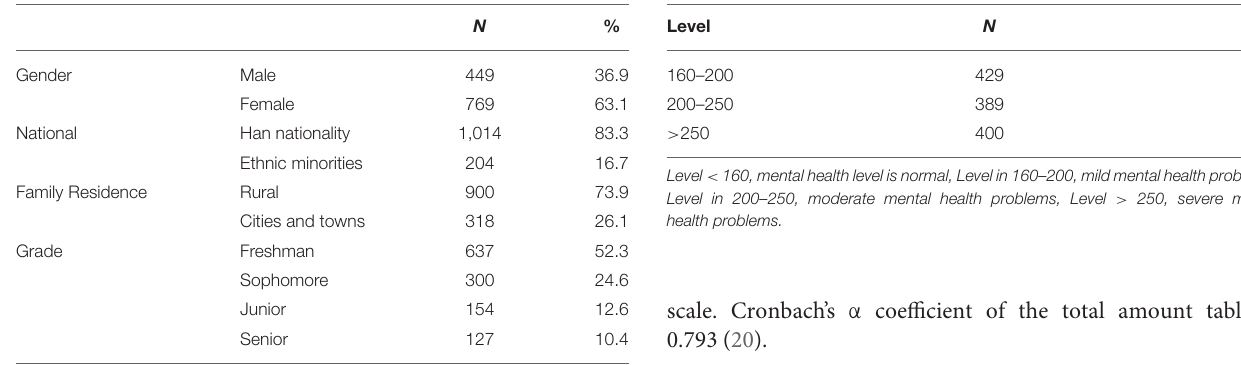
TABLE 1 | Basic information of the respondents. TABLE 2 | Mental health of college students during the COVID-19